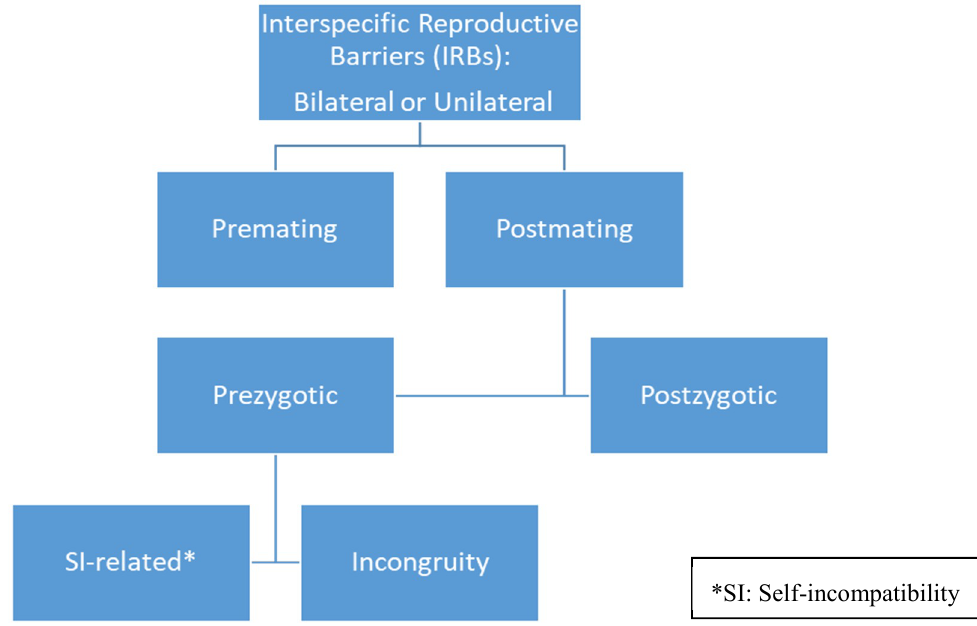
Figure 1. Interspecific reproductive barriers (IRBs) can operate at di ff erent levels in the path from pollen delivery to the formation of viable hybrid o ff spring. SI-related prezygotic IRBs are believed to rely on components of the self-incompatibility outbreeding system to actively inhibit heterospecific pollen on or in the pistil of the female partner. Incongruity encompasses all other prezygotic IRBs, and is thought to rely on passive mechanisms that manifest as suboptimal pollen performance in a heterospecific pistil. Incongruity includes conspecific pollen precedence, in which conspecific pollen tubes grow much better in the pistil than do heterospecific pollen tubes. At the mechanistic level, incongruity is the least understood of all the IRBs.